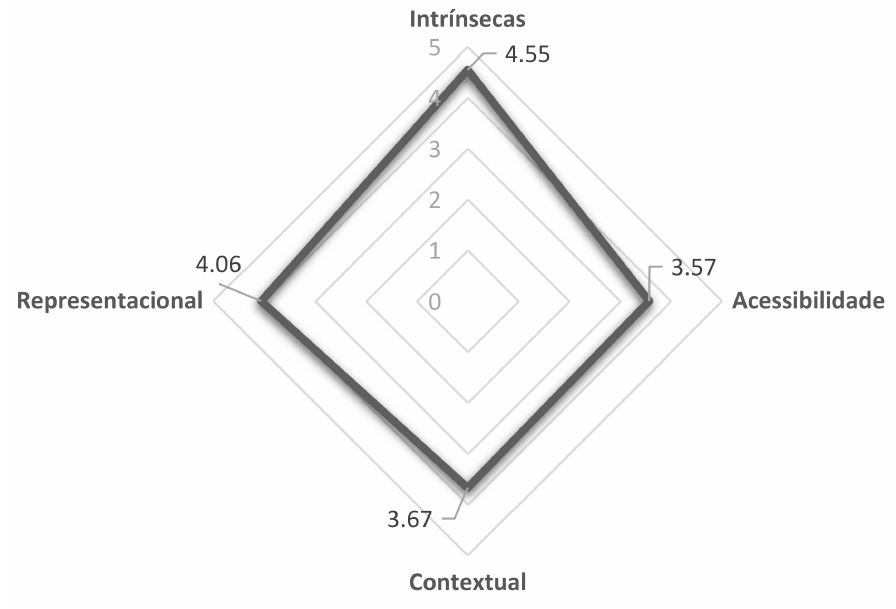
Figure 4. Average per